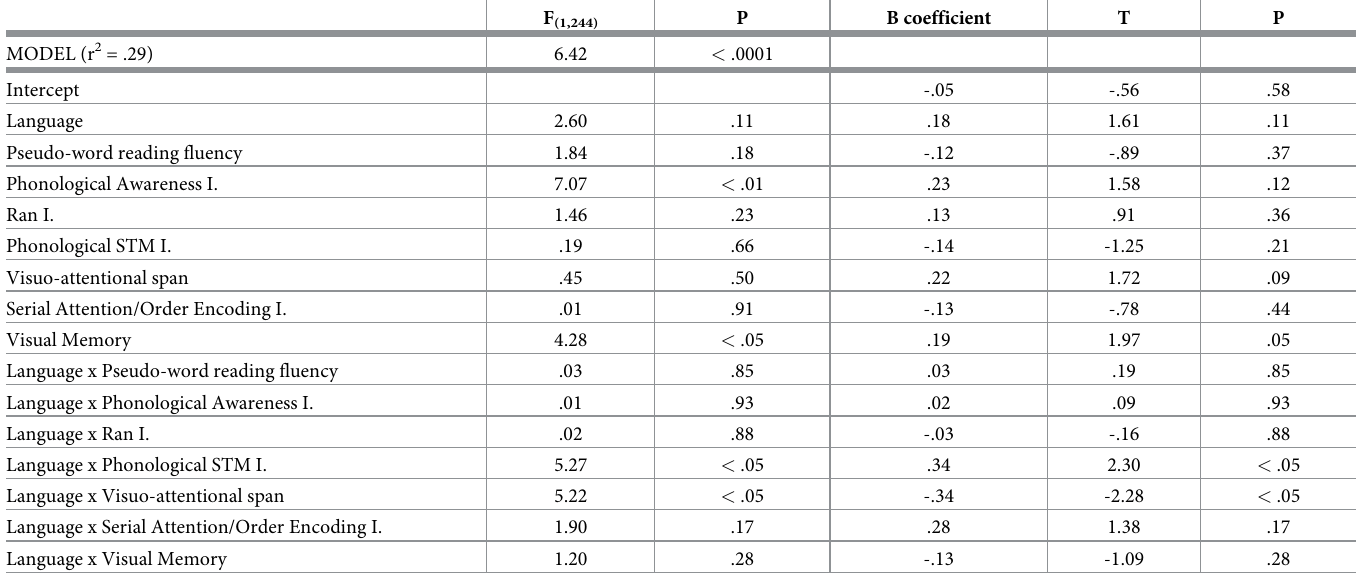
Table 6. Results of regression analysis with the lexical learning scores as dependent variable, and language and the scores in the other cognitive tasks as predictors. Note that, in the case of Language and interactions with Language, the coefficient refers to Italian (taken as reference language). I. =